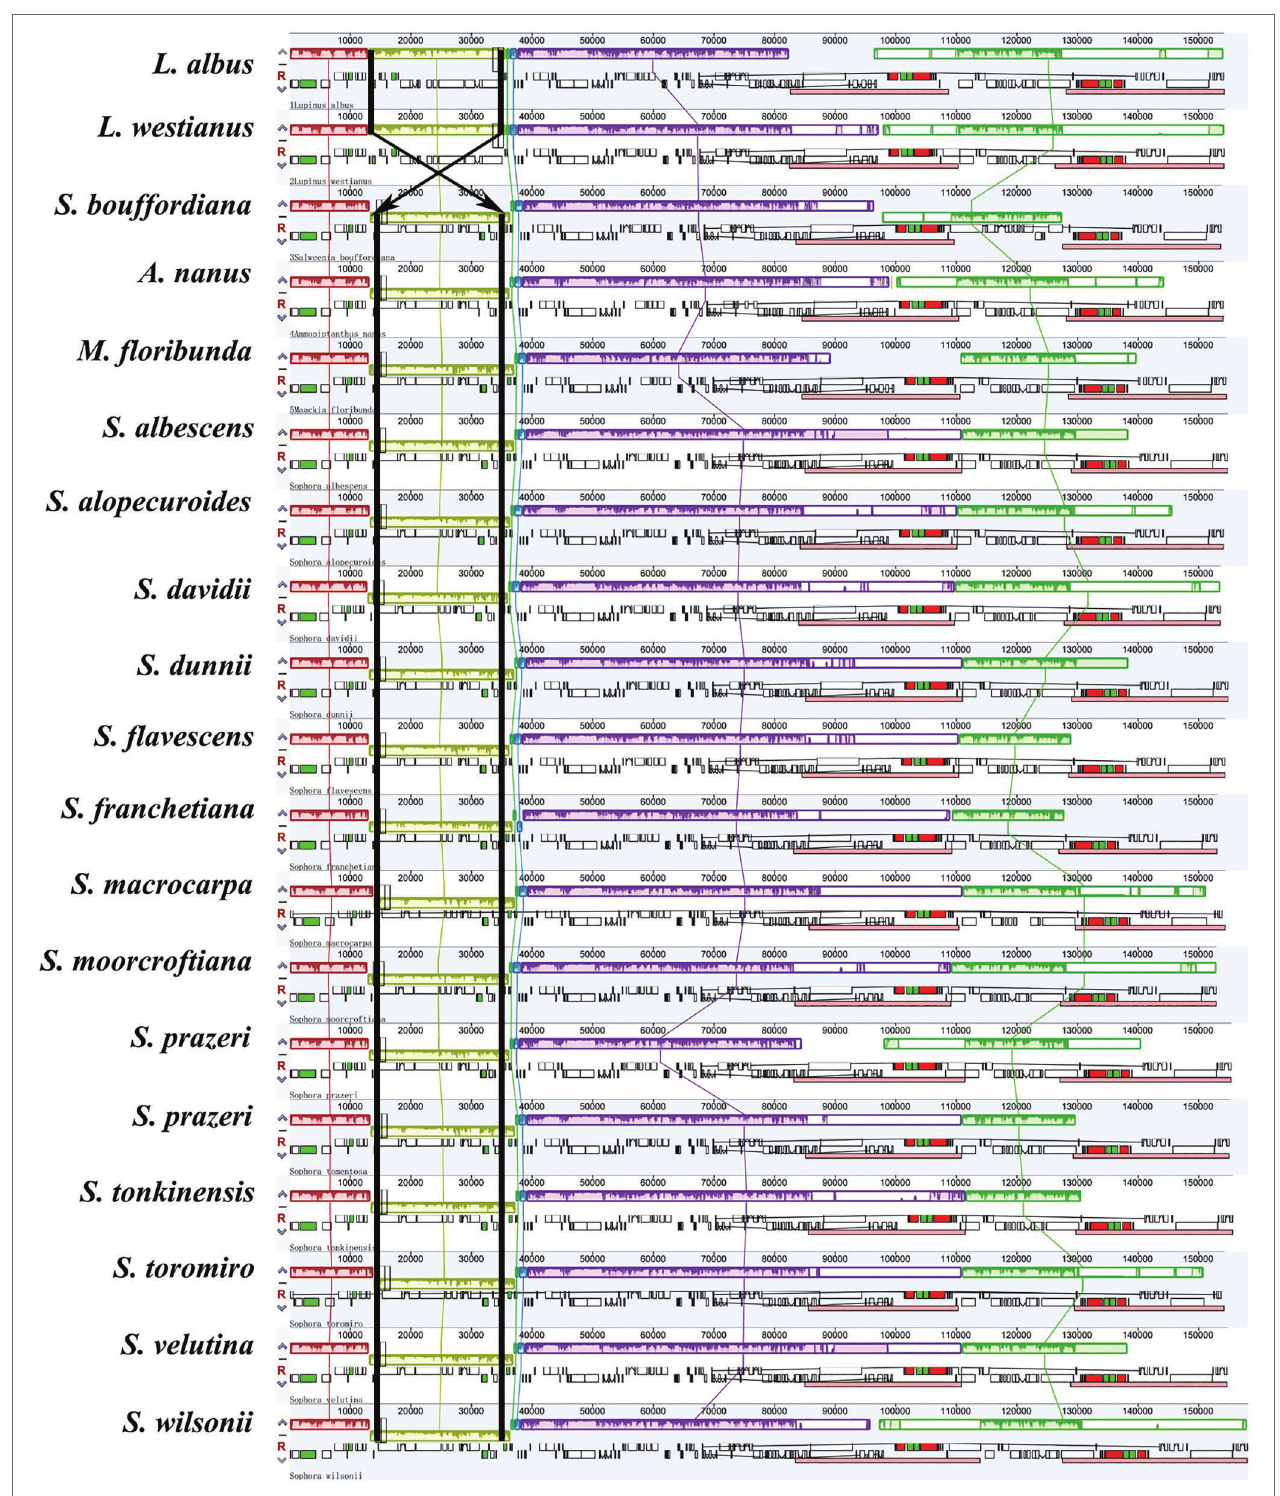
FIGURE 3 | Genes arrangement using Mauve alignment in the 14 Sophora plastid genomes (White block: protein coding genes, black block: tRNA genes, green block: intron-containing tRNA genes, red block: rRNA